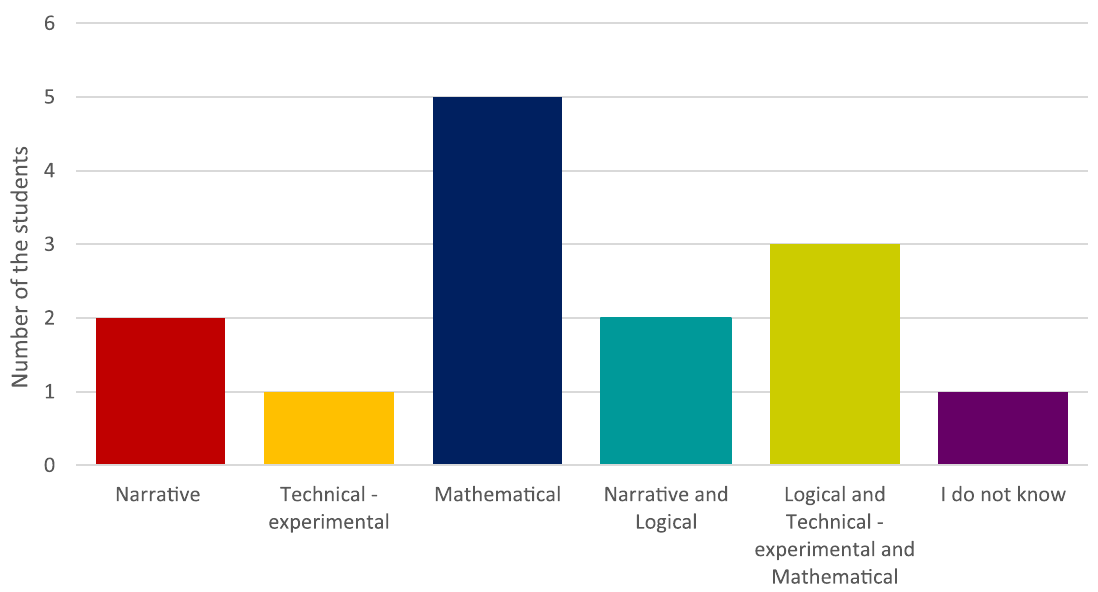
FIG. 21. Distribution of the students ’ preference of the